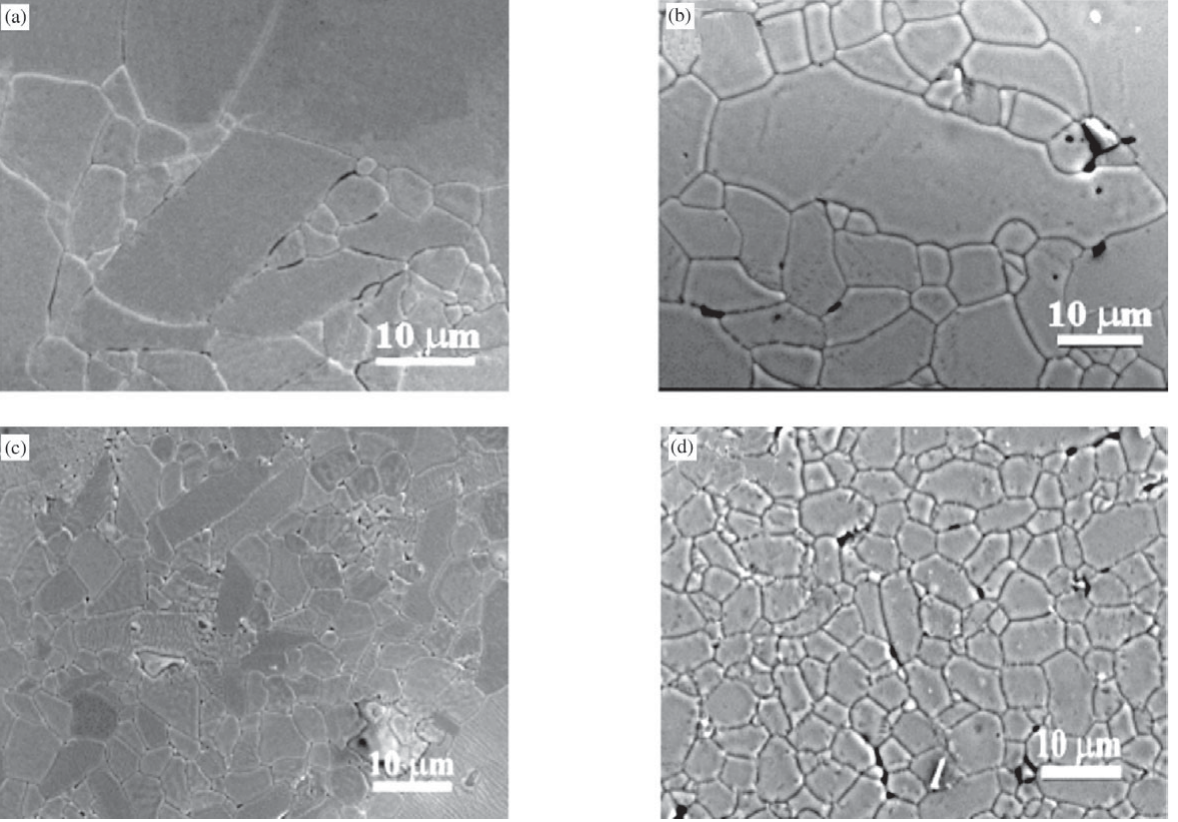
Figura 5. Microestrutura das superfícies polidas e atacadas termicamente das cerâmicas sinterizadas no segundo estágio em 1350 °C, de a) SBN53/47 HF ( ⊥ ); b) SBN63/37 HF ( ⊥ ); c) SBN53/47 (SC); d) SBN63/37 (SC) (SC- sinterização convencional).